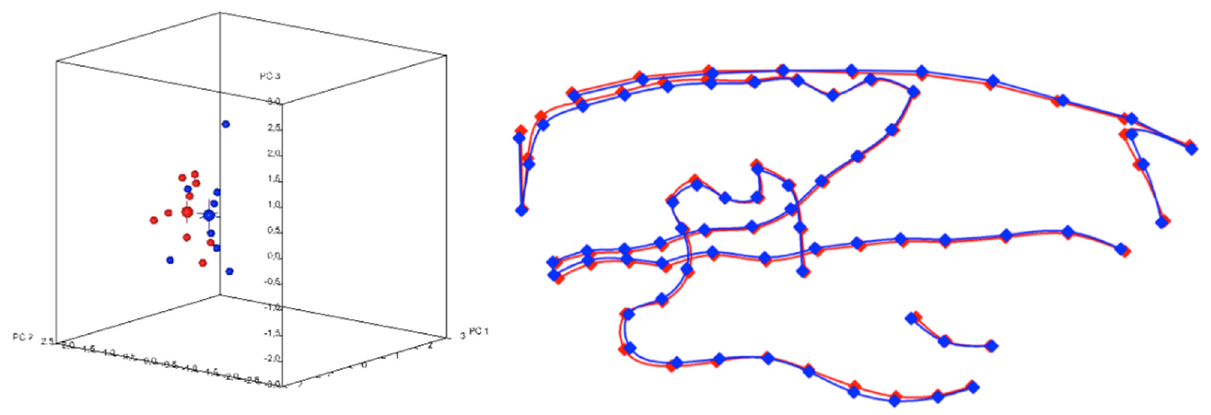
Figure 3. Plot of sample and corresponding superimposition of the mean tracings of the two groups.